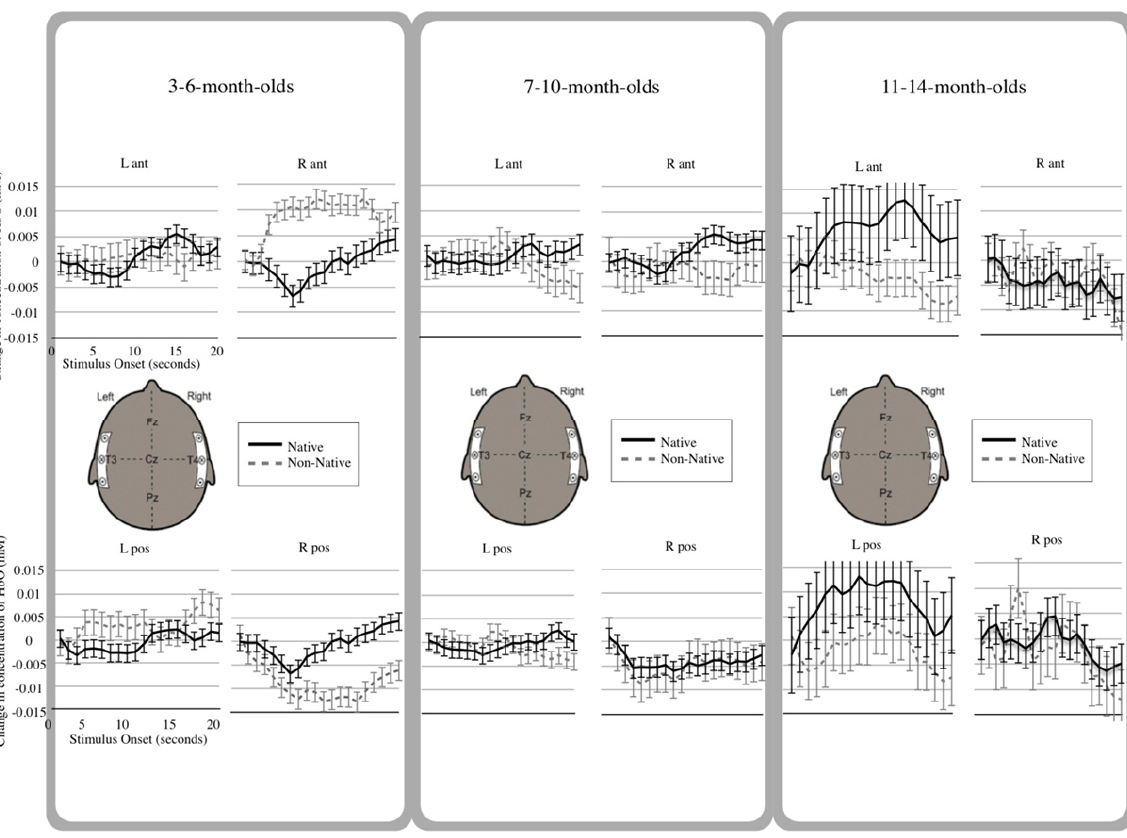
Figure 2. Hemodynamic Response Functions. Native speech is plotted in black, Non-Native speech is plotted in dashed gray. Each channel location is shown: Right Anterior (R ant), Right Posterior (R pos), Left Anterior (L ant) and Left Posterior (L pos). Error bars represent standard error of the estimate. Data from 3-to-6-month-olds are in the left panel; those from 7-to-10-month-olds are in the middle panel, and those from 11-to-14-month-olds are in the right